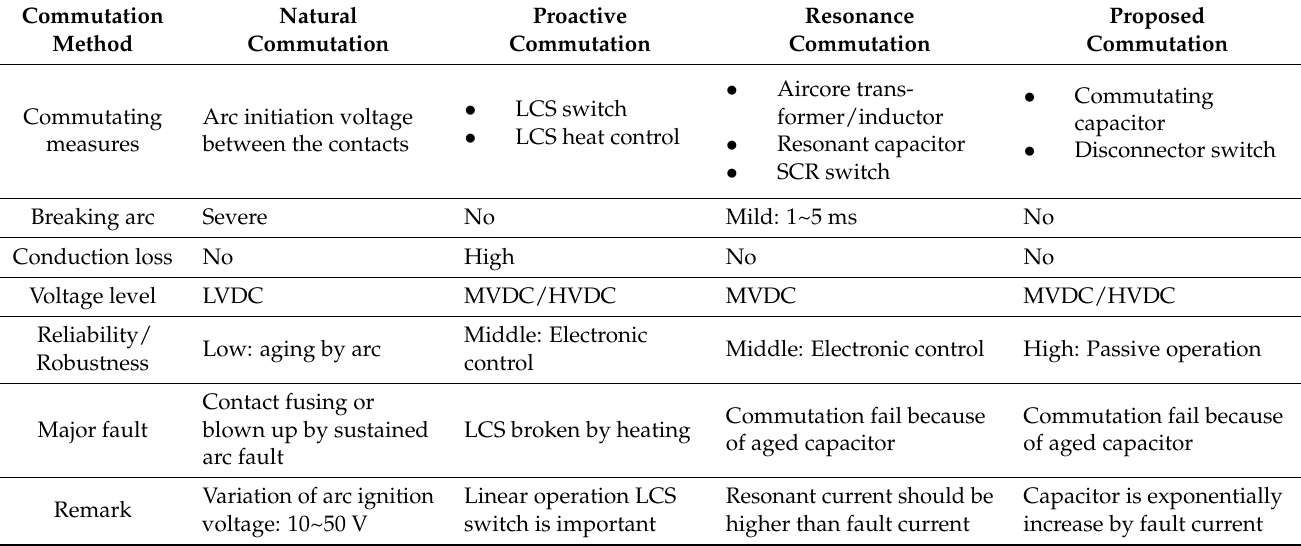
Table 1. Pros and cons of typical commutation method in hybrid circuit